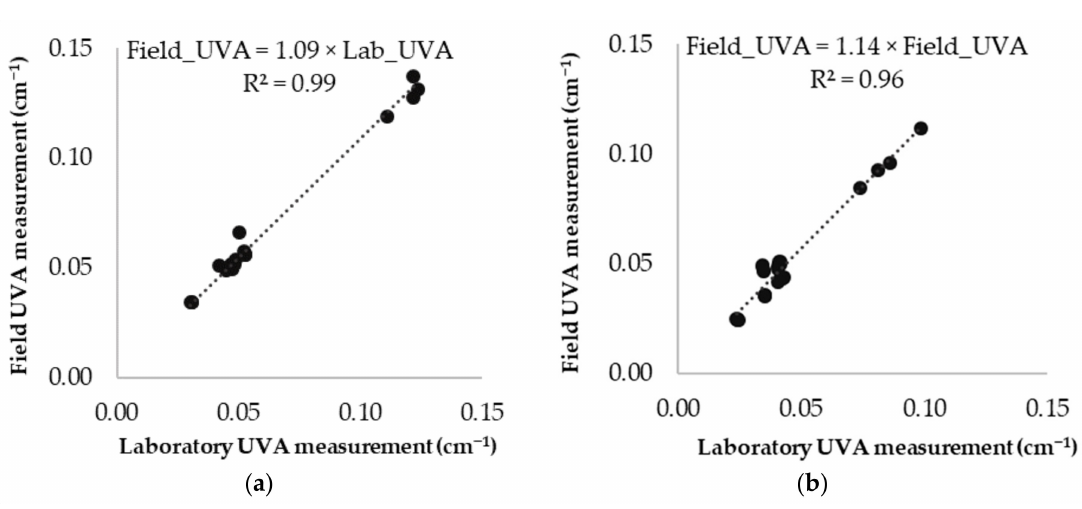
Figure 3. Validation of real-time field measurements with laboratory measurements: ( a ) FW field instrument (filtered water); ( b ) TW field instrument (treated